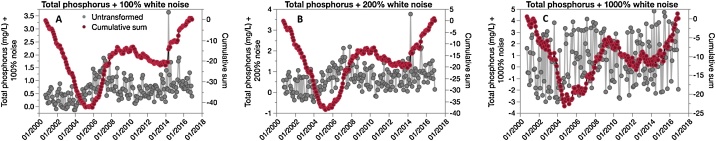
Cumulative sums calculated from the total phosphorus time-series presented in Fig. 1, with addition of white noise to test sensitivity of the cumulative sums transformation to noisy datasets. Cumulative sums of time-series with increased noise are presented in red, with the cumulative sum of the original data presented in gray for reference. A) Cumulative sum of the original time-series with +100% white noise, B) cumulative sum of the original time-series with +200% white noise, and C) cumulative sum of the original time-series with +1000% white noise.